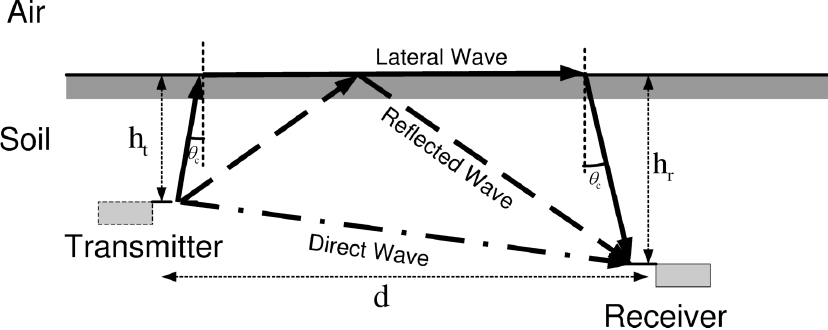
Figure 5. The direct, reflected, and lateral waves in the underground channel